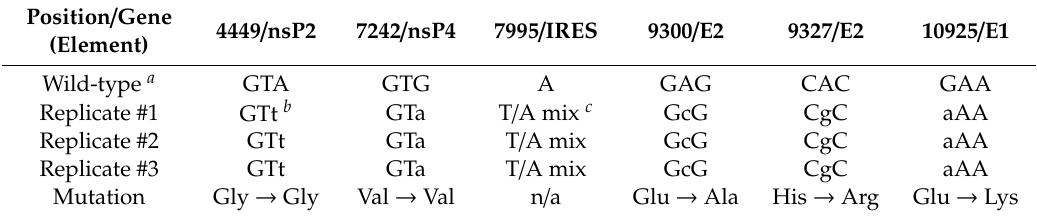
Table 1. Summary of consensus mutations following ZPC/IRESv1 passaging.